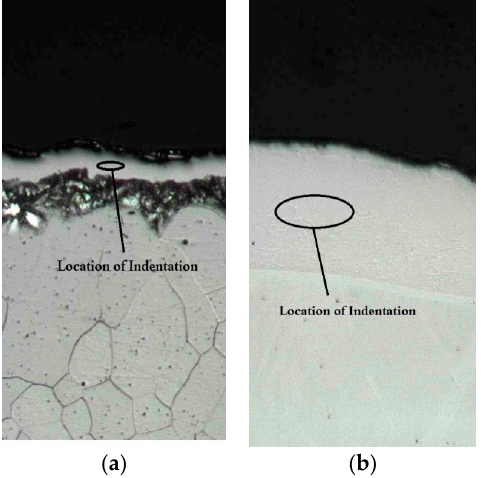
Figure 13. Location of the area where the micro-indentation hardness test was conducted for the chromized coatings ( a ) low carbon steel, and ( b ) 316 stainless steel substrates.